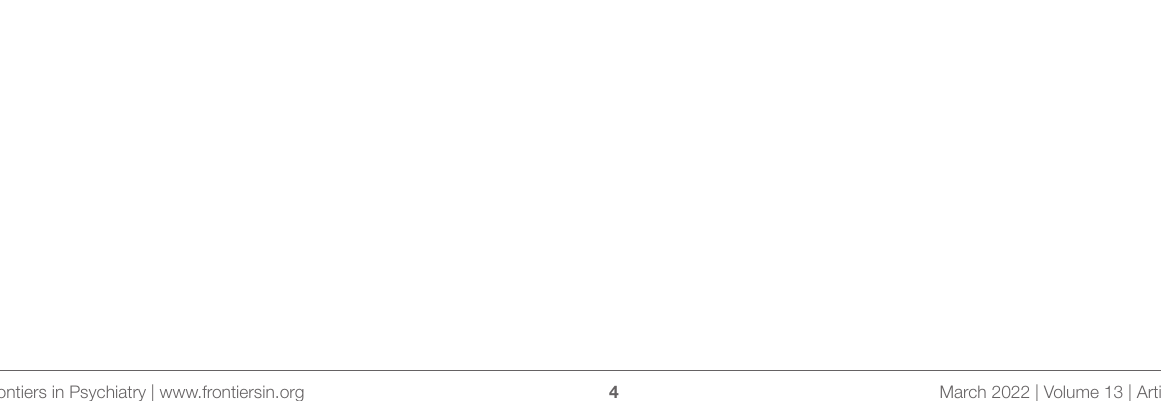
Frontiers in Psychiatry |